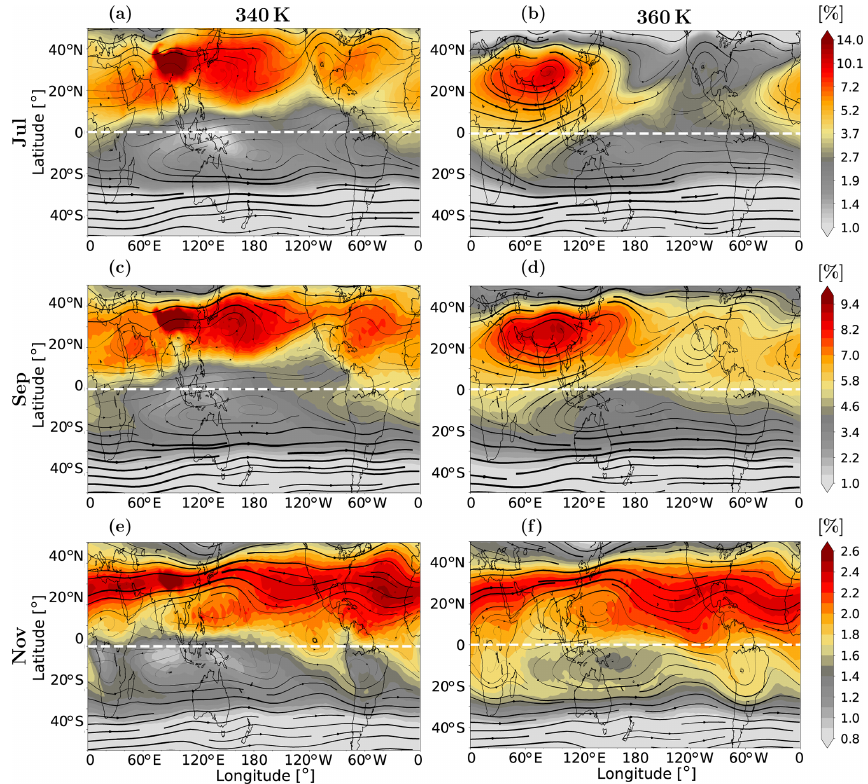
Figure 8. A snapshot of the horizontal distribution of the NH-extratropical-origin young ( < 3 months) air on the 340 and 360K isentropic surface during July, September, and November. Streamlines show horizontal